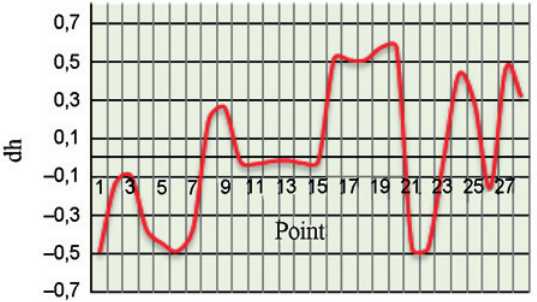
Fig. 11. Selected points for DEM evaluation Fig. 12. Determined DEM height points